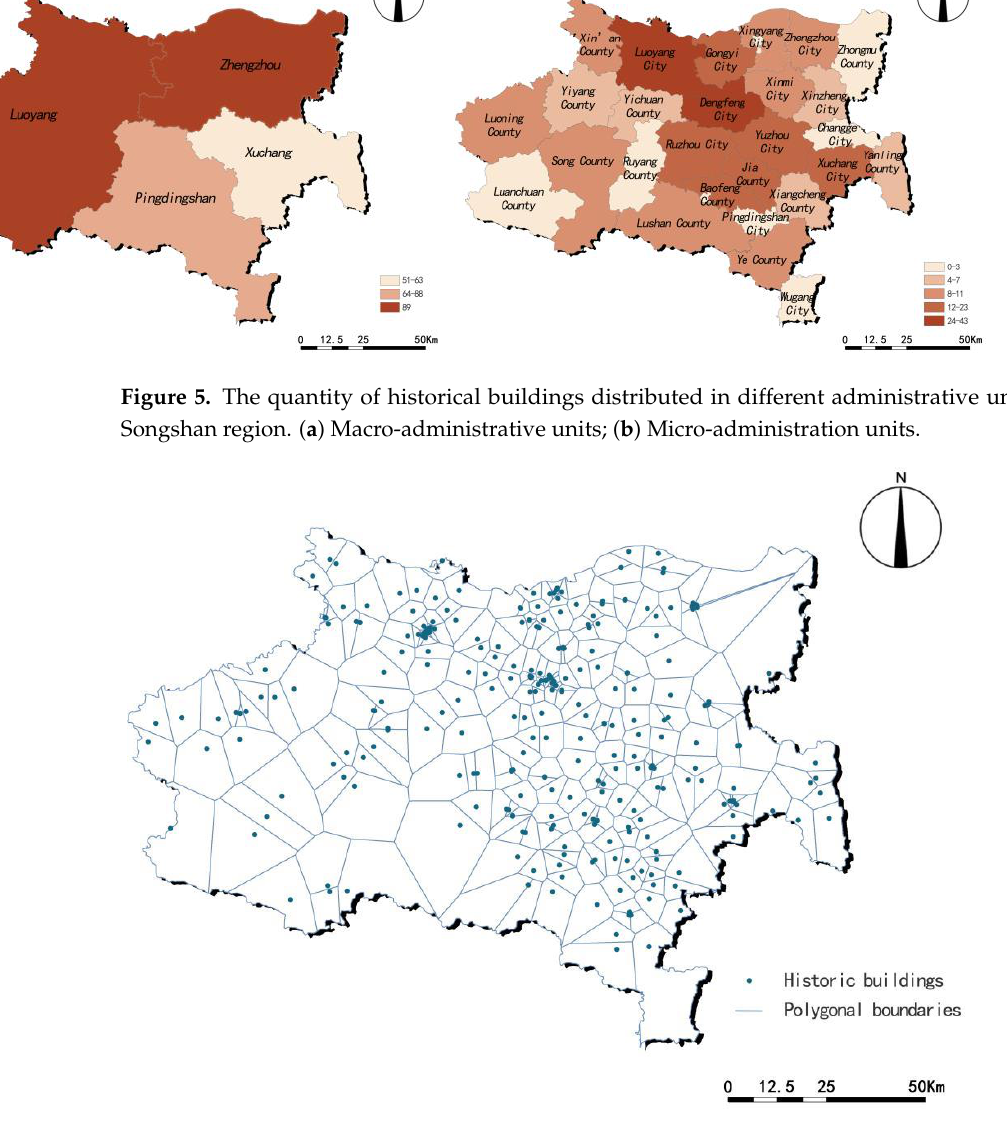
Figure 5. The quantity of historical buildings distributed in different administrative units in the Songshan region. (a) Macro-administrative units; (b) Micro-administration units.